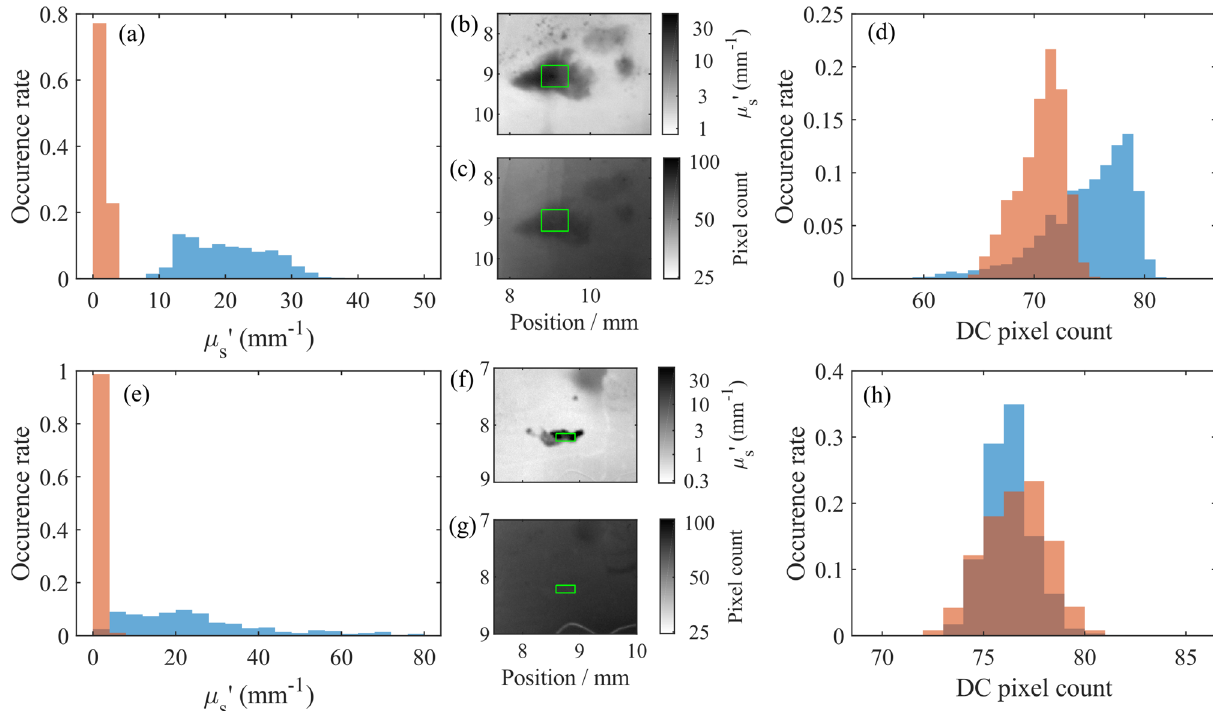
Figure 5. Reduced scattering coefficient ( a , e ) and uniform illumination pixel count ( d , h ) taken from the tooth in Fig. 3c (top) and d (bottom) for cavities (blue) and healthy tissue (orange). Occurrence rate is the probability of a pixel scattering coefficient being in each bar. The center column shows the cavity reduced scattering coefficient ( b , f ) and near infrared uniform illumination ( c , g ), both shown on a logarithmic scale. The green box shows the caries shown in the histograms, the healthy tissue shown in the histogram is taken from healthy regions of the same tooth (not shown in the